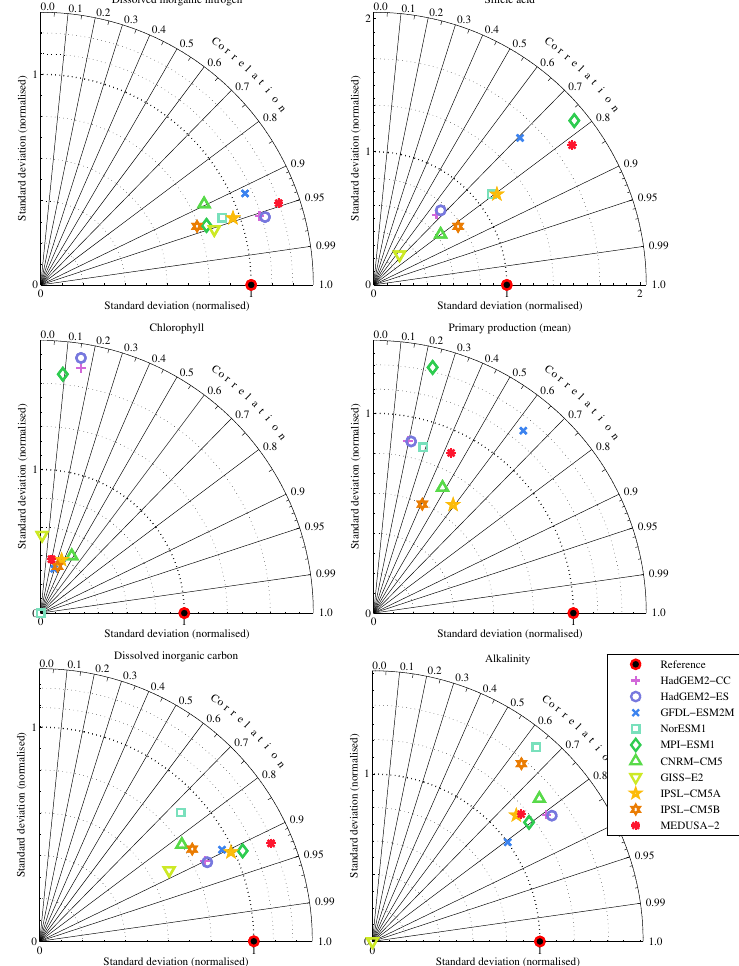
Fig. 41. Taylor diagrams of the performance of M EDUSA -2.0 and a selection of CMIP5 models for a range of biogeochemical properties: dissolved inorganic nitrogen (top left), silicic acid (top right), chlorophyll (middle left), primary production (middle right), dissolved inorganic carbon (bottom left) and alkalinity (bottom right). In each case, diagrams show spatial model-observation comparisons based on annual average fields. All diagrams share a common model key.